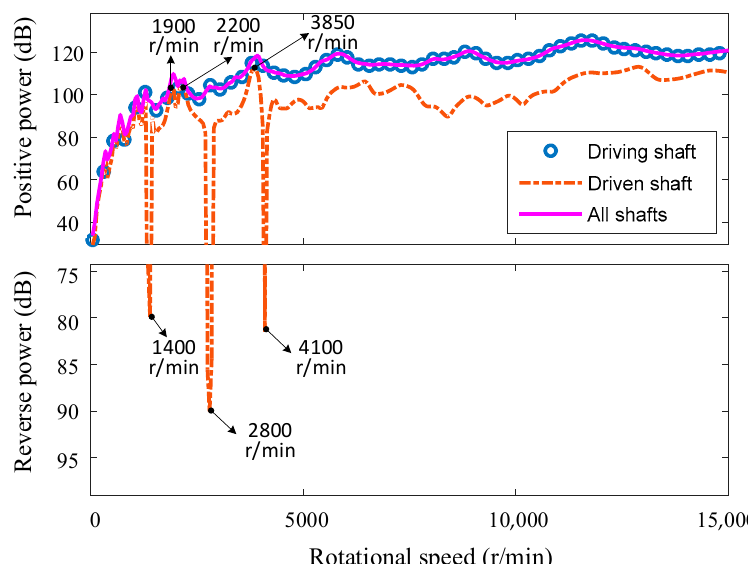
Figure 9. Gear shaft transmitted power flow—location path.